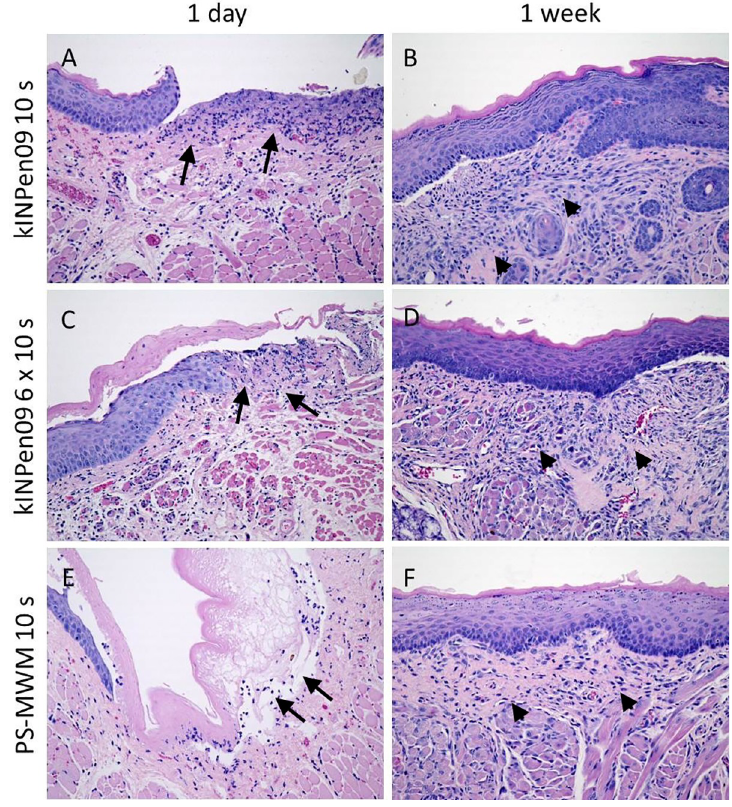
Fig 5. Histological examinations of plasma treated groups. A, C, E: Cheek mucosa with ulceration and inflammation in the stroma (arrows) one day after the treatment with CAP (A kINPen09 10s, C kINPen09 6x10s, E PS-MWM 10s). B, D, F: Cheek mucosa one week after the CAP treatment (B kINPen09 10s, D kINPen09 6x10s, E PS-MWM 10s) with reepithelialization and remnants of granulation tissue (arrow heads). (A-F: HE, original magnification